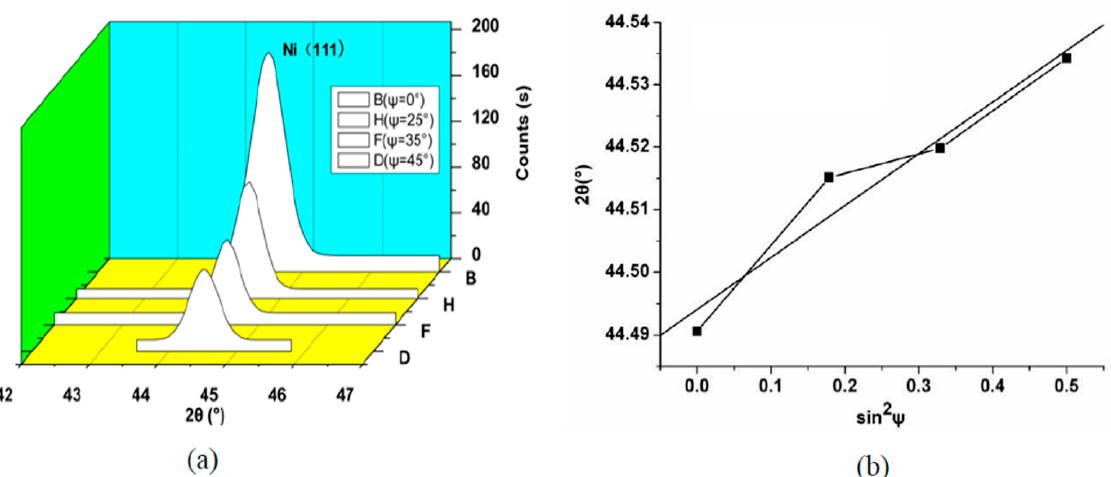
ψ (80 kHz, 100 W); ( b ) the slope